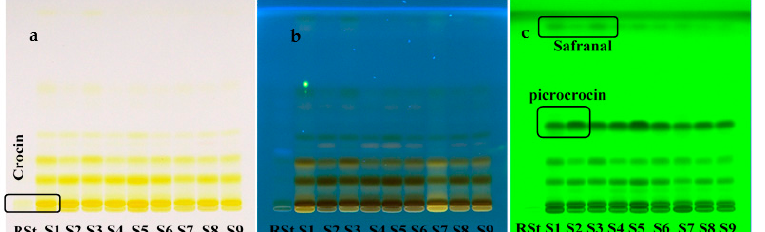
Figure 2. Chromatograms of saffron methanolic extracts in the HPTLC analysis: ( a ) under daylight and ( b ) at 366 nm before derivatization; ( c ) after derivatization with anisaldehyde at 254 nm.